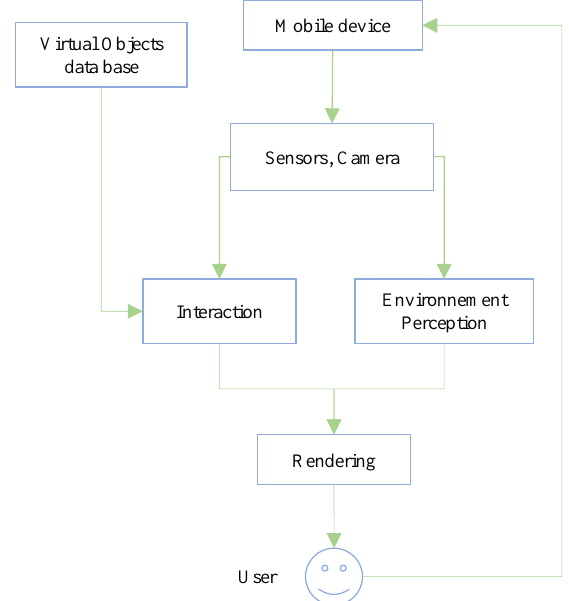
Figure 2. Augmented reality simplified process